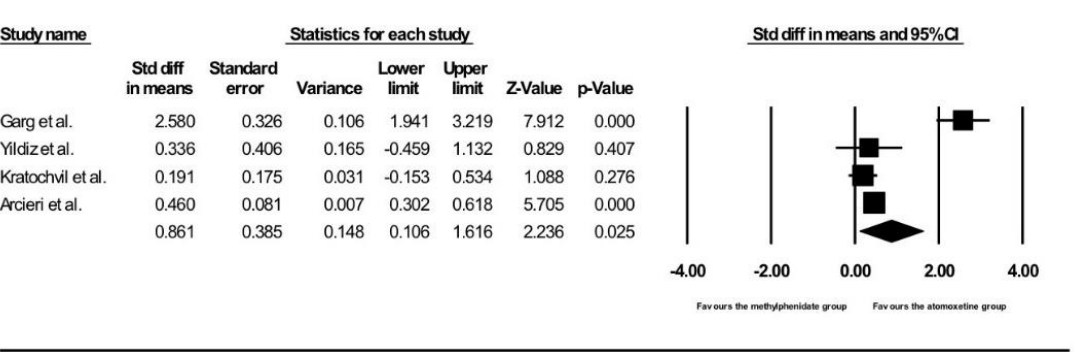
Figure 3. Forest plot of on post- vs. pre-treatment HR between children and adolescents receiving methylphenidate and atomoxetine treatment. Table 3. Meta-regression analysis that explored the source of heterogeneity on post- versus pre-treatment HR between children and adolescents receiving methylphenidate and atomoxetine